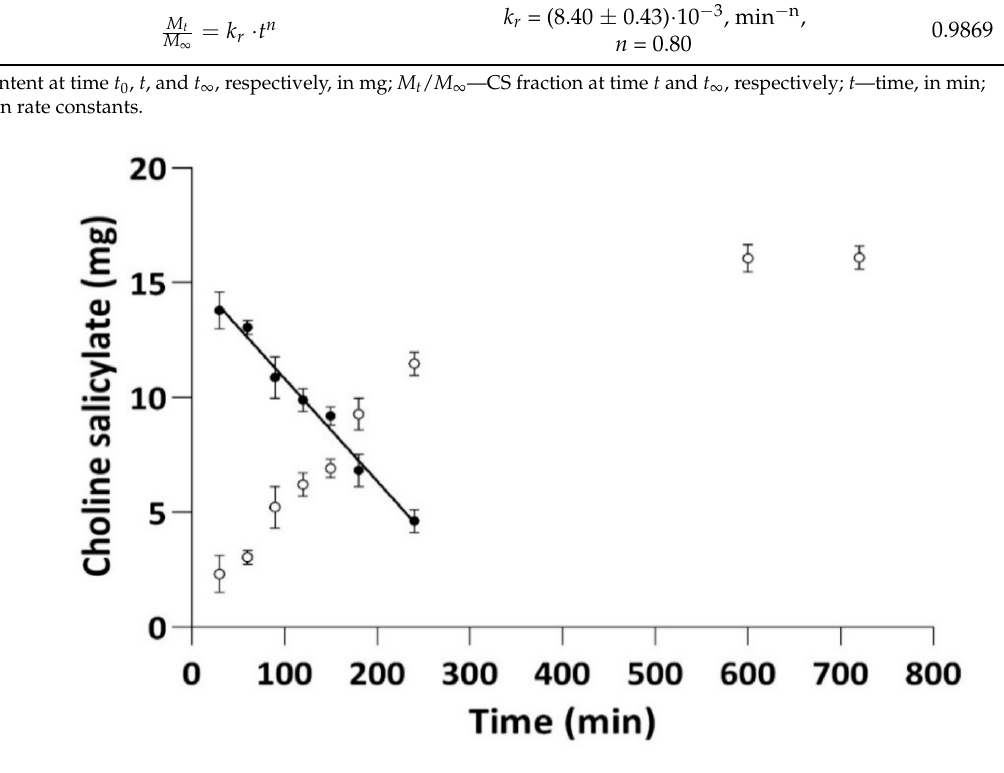
Figure 2. The ability of CS to penetrate the hydrophilic membrane (regenerated cellulose) for eye drops with CS (2%) and HA (0.4%). Plots of the relationship: the content of CS in the acceptor part of the Franz cell as a function of time; Q = f(t) ( ) and differential chart Q ∞ − Q t = f(t) ( • (cid:35)